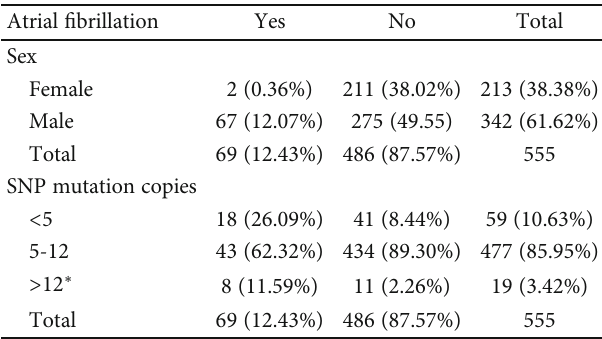
Table 1: Demographical information, admixture analysis, and European-related SNP association with AF in PRH.